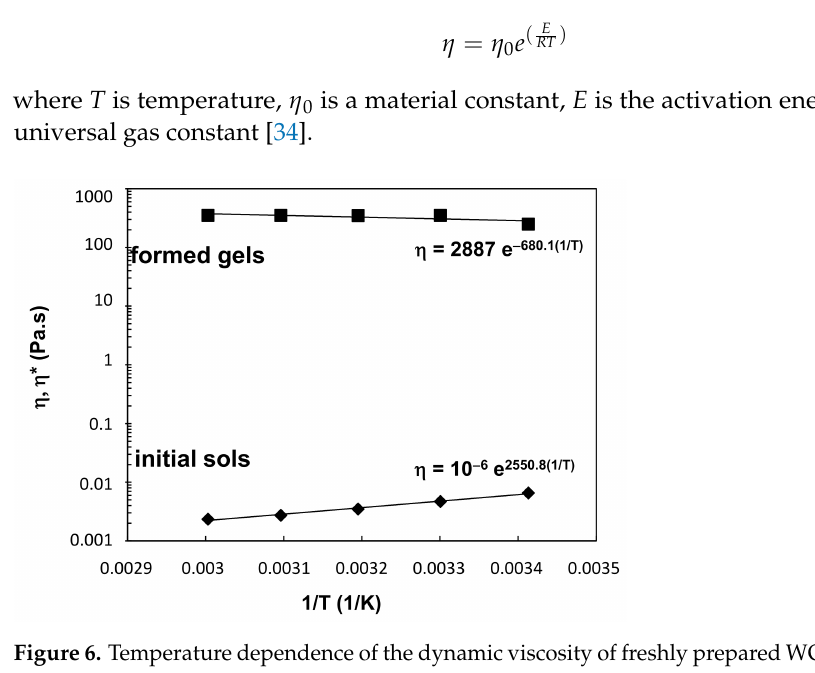
Figure 6. Temperature dependence of the dynamic viscosity of freshly prepared WO 3 sol and complex viscosity of gels, formed at different